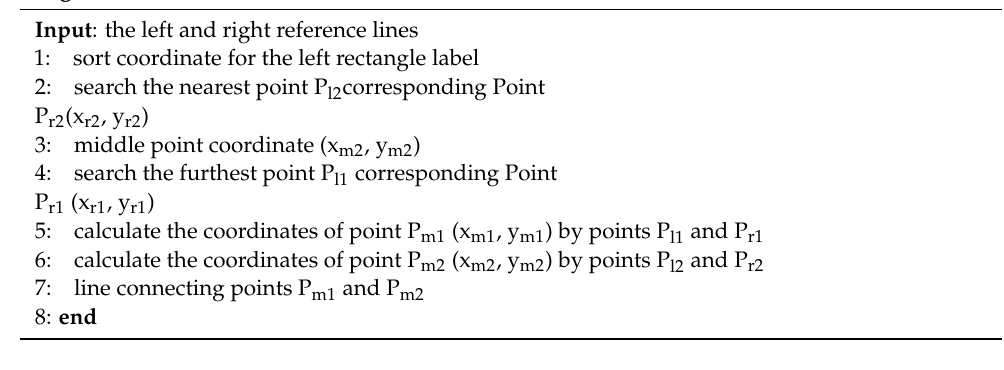
Algorithm 3 Obtain the centerline